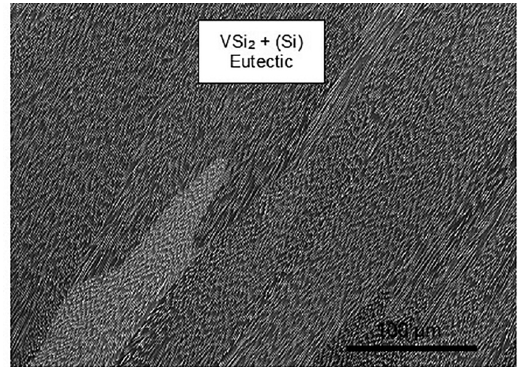
Figure 5: SEM/BSE micrograph of the V95.0Si as-cast alloy.